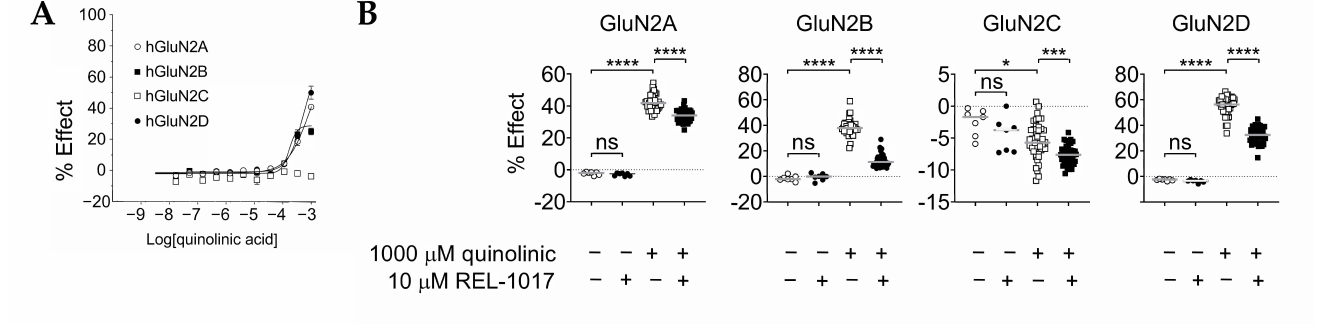
Figure 1. ( A ) Quinolinic acid (QA) is a subtype-selective N-methyl-D-aspartate receptor (NMDAR) partial agonist. QA concentration–response curve (CRC) was performed in the absence of L-glutamate by fluorometric imaging plate reader (FLIPR) calcium assay, using the Chinese hamster ovary (CHO) cell lines expressing the indicated heterodimeric NMDAR. QA, at the two highest tested concentrations, 333 µ M and 1000 µ M, increased intracellular calcium ([Ca 2+ ] in ) in GluN2A-, GluN2B-, and GluN2D-expressing cell lines, with estimated an EC 50 of 850 µ M, 170 µ M, and 520 µ M for GluN2A, GluN2B, and GluN2D receptors, respectively. Estimated maximal asymptotic response was 75%, 28%, and 71% of that evoked by 10 µ M L-glutamate for GluN2A, GluN2B, and GluN2D receptors, respectively. GluN2C-expressing cells were not activated by any tested concentration of QA. Data are mean ± standard error of the mean (SEM), n = 6 wells per group, and were fitted using four-parametric logistic equation with GraphPad Prism v8.0. ( B ) It was shown that 10 µ M REL-1017 reduced calcium entry in the presence of 1000 µ M QA. QA 1000 µ M increased [Ca 2+ ] in up to 41%, 37%, and 55% in GluN2A, GluN2B, and GluN2D NMDAR subtypes, respectively. In addition, 10 µ M REL-1017 significantly ( p < 0.0001) decreased these values to 34%, 12%, and 32% in GluN1-GluN2A, GluN1-GluN2B, and GluN1-GluN2D NMDAR subtypes, respectively. In the GluN1-GluN2C cell line, [Ca 2+ ] in was − 5.5% and − 7.6% after 1000 µ M QA and 1000 µ M QA plus 10 µ M REL-1017, suggesting a reduction in baseline NMDAR-mediated [Ca 2+ ] in , possibly due to an endogenous low-level L-glutamate release by the CHO cell line. Data ( n = 7 wells for buffer and REL-1017 groups, n = 42 wells for the remaining groups) are shown as scatter dot plot, and median value is indicated. **** is p < 0.0001; *** is p < 0.001; * is p < 0.05; ns is not statistically